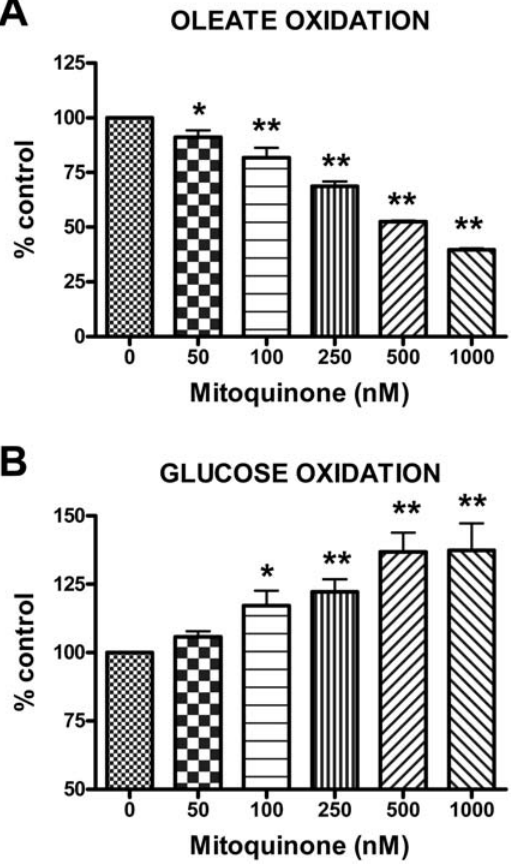
Figure 8. Dose-dependent effect of mitoquinone compared to vehicle on glucose and oleate oxidation. BAE cells were incubated overnight (16 h) in the presence of culture medium with 5.5 mM glucose. [1- 14 C]oleic acid (panel A) or D-[ 14 C(U)]glucose (panel B) along with 50 m M oleate were added at time 0 and cells incubated for 120 min before trapping CO 2 . Final glucose and oleate concentrations after addition of label were 5.6 mM glucose + 50 m M oleate (panel A) or 5.5 mM glucose + 56 m M oleate (panel B). Data are expressed relative to incubation in the presence of vehicle alone. Data represent mean 6 SE (n=4 for each determination). * p , 0.05 or ** , 0.01 compared to vehicle by one-way ANOVA with repeated measures.